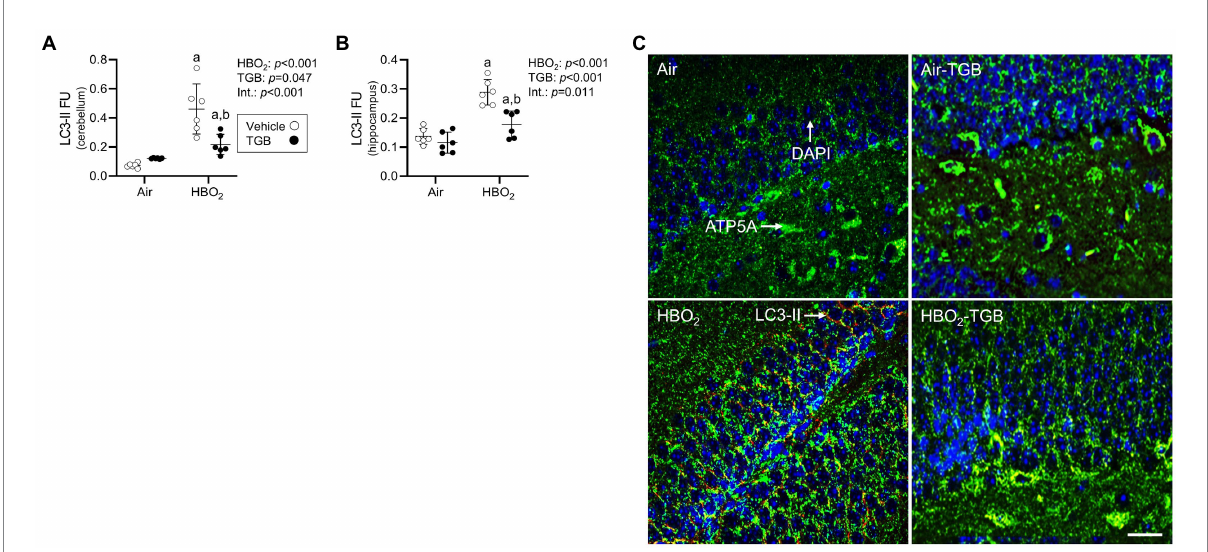
FIGURE 6 Autophagosome formation in mice exposed to extreme HBO 2 . Mice were pretreated with 0.9% NaCl or TGB (4.8 mg/kg body weight) 30 min before exposure to air or 5 ATA oxygen for 30 min. (A,B) Quantification of LC3-II in the cerebellum and hippocampus. (C) Representative images from hippocampus. LC3-II (red), ATP synthase F1 subunit α (green) and DAPI (blue). LC-II merged with ATP5A indicates mitophagy. Scale bar = 100 μ m. Main effect of a HBO 2 and b TGB, p < 0.05.